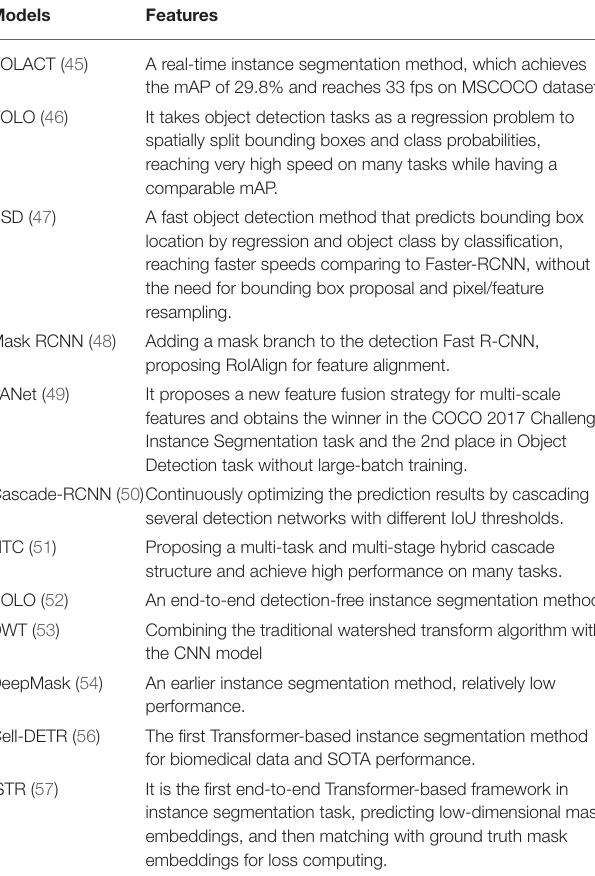
TABLE 3 | Features of instance segmentation